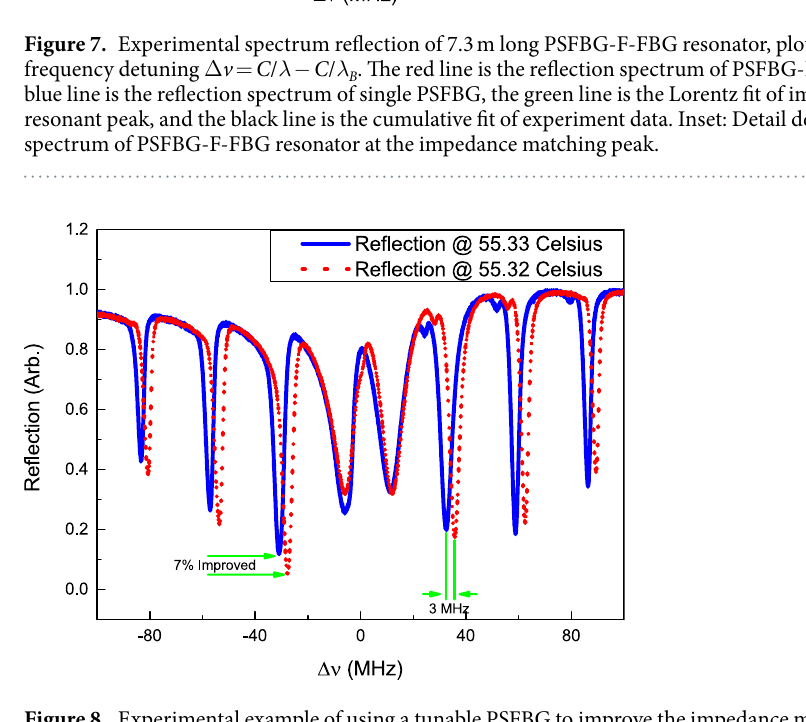
Figure 9 shows the experimental and theoretical FSR (black line with round points and black line with square points respectively) and linewidth (FWHM) (blue line with hexagonal points and blue line with triangular points respectively) of the PSFBG-F-FBG resonator with a cavity length of 3.4 m. The experimental results agree well with the theoretical predictions with a large index number where means a large frequency detuning between the